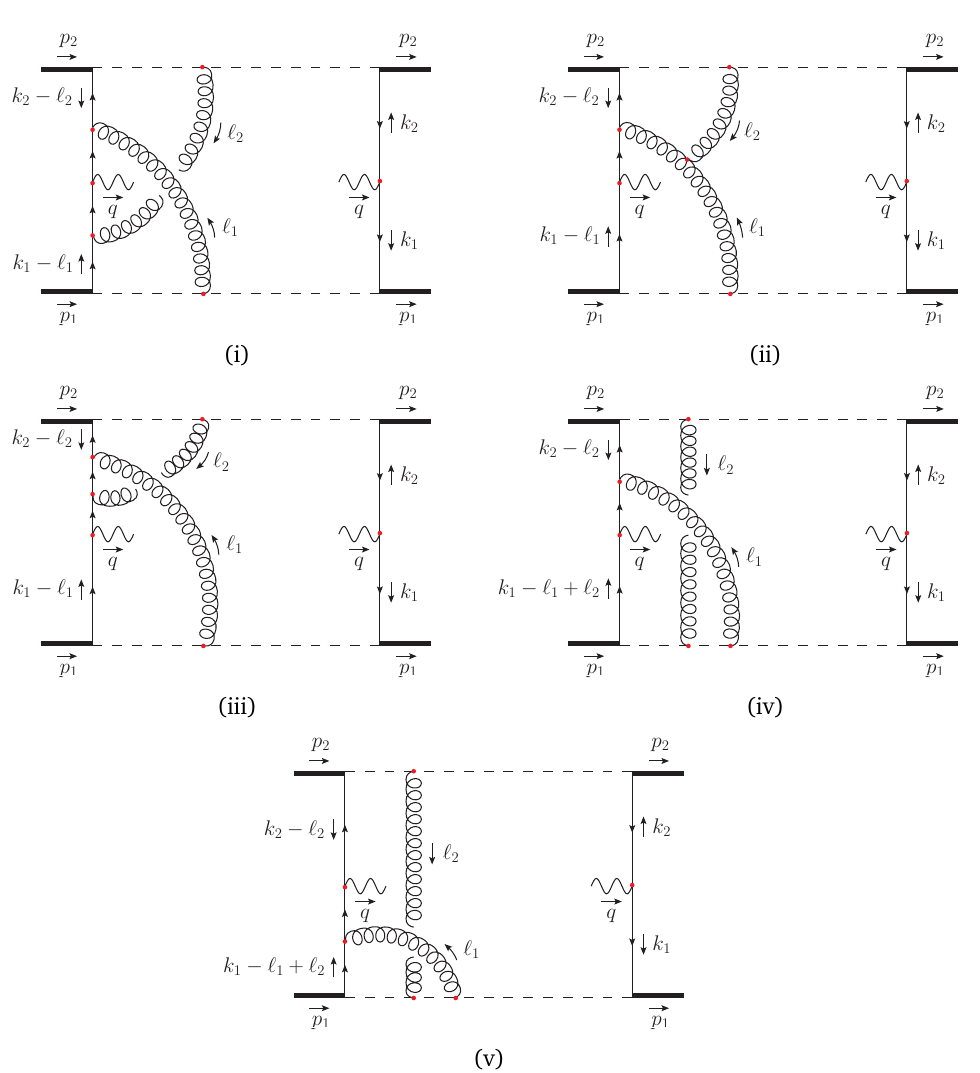
Figure 6: A diagram contributing to the dBM part of the DY cross section in the model at (cid:79) ( α 2 that does not have a ‘colour-entangled’